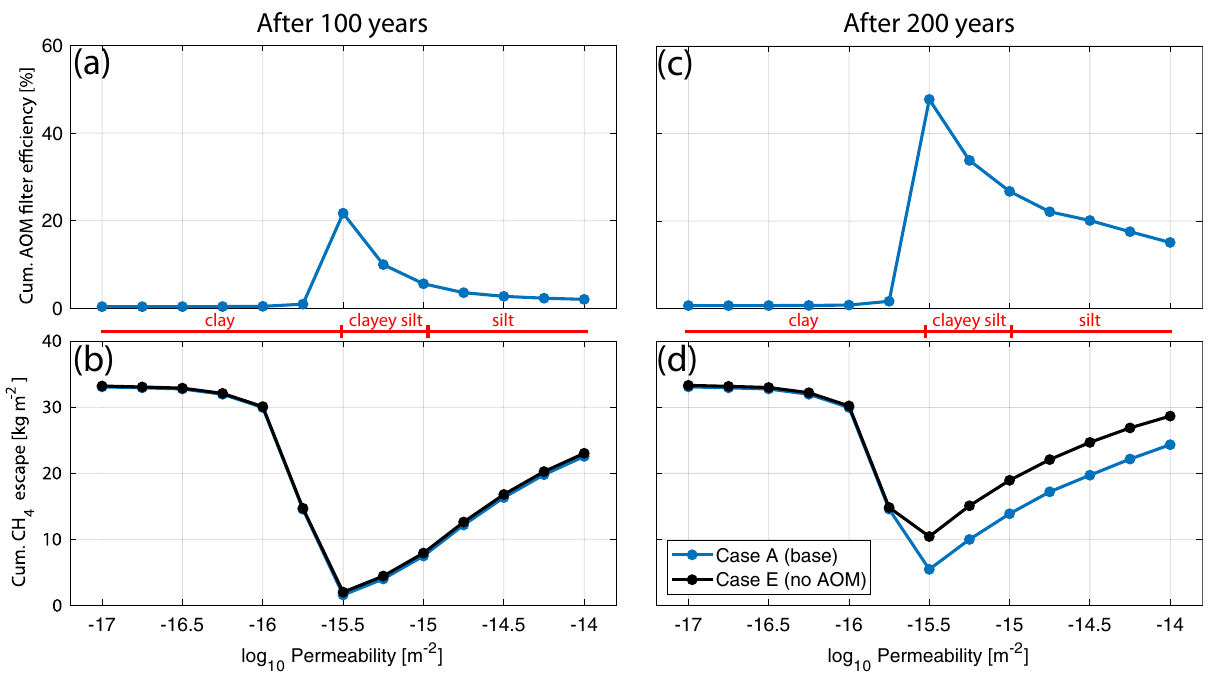
Fig. 5 Summary of modeling results. Model simulation results after 100 years ( a , b ) and after 200 years (c-d). Cumulative anaerobic oxidation of methane (AOM) fi lter ef fi ciency ( a , c ) and cumulative gas escape ( b , d ) plotted against intrinsic permeability for Case A (baseline, blue) and Case E (no AOM, black). Note that the blue line is essentially hidden behind the black in ( b ), meaning that AOM has a negligible mitigating effect on sea fl oor emissions over the fi rst 100